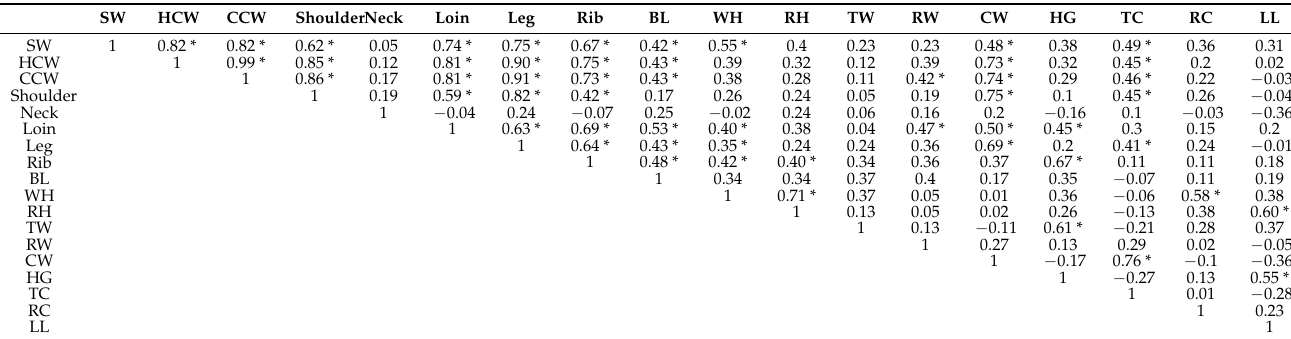
Table 2. Pearson’s correlation coefficients between biometric measurements and carcass traits of sheep finished in tropical